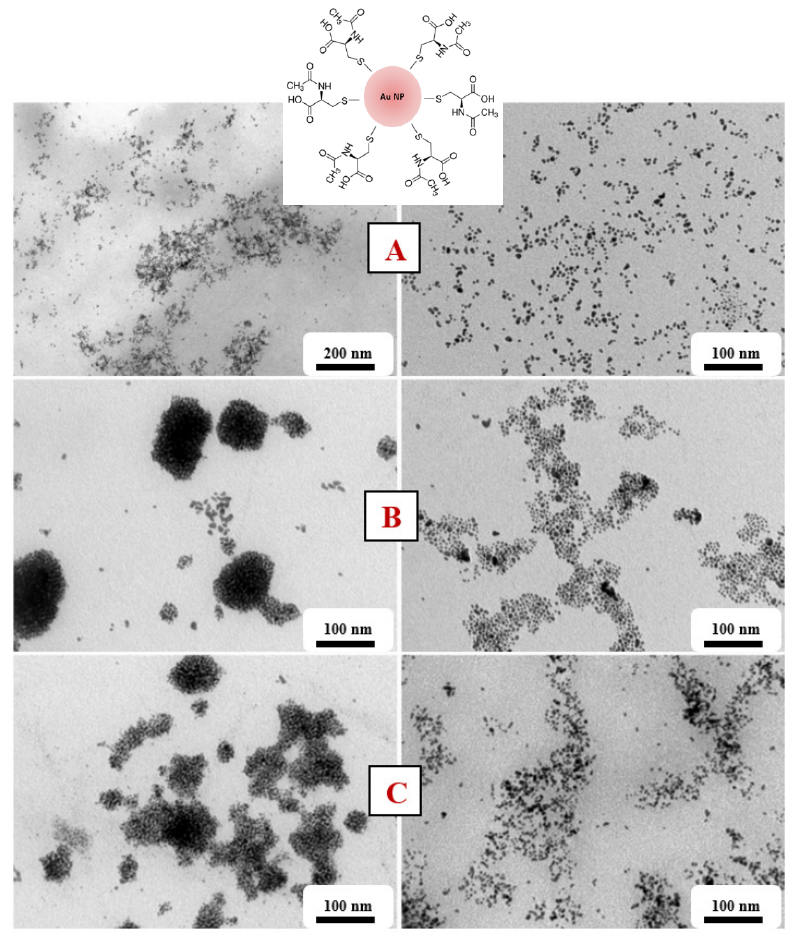
Figure 7. TEM AuNP images in PEG/NALC/H 2 O prepared with a deposition time of 900 s. ( A ) NALC/H 2 O solution (0.5 g/100 mL), ( B ) TCD/H 2 O solution (1.0 g/100 mL), and ( C ) TCD/H 2 O solution (1.5 g/100 mL). Right column after washing with distilled water. A scheme of a grafted Au nanoparticle with NALC is also introduced.